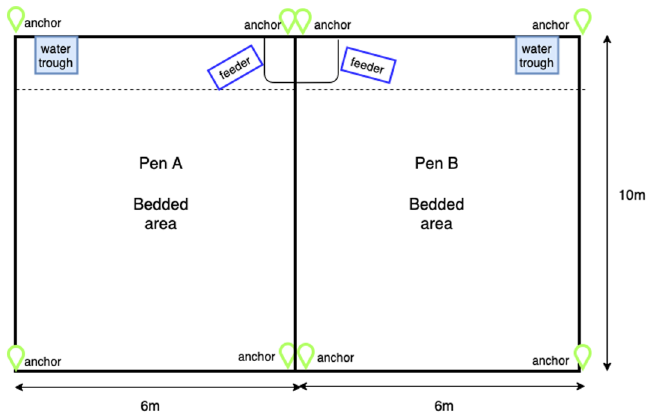
Figure 1. Diagram of the two pens used during this study, indicating the position of anchor sensors, the feeder and water trough